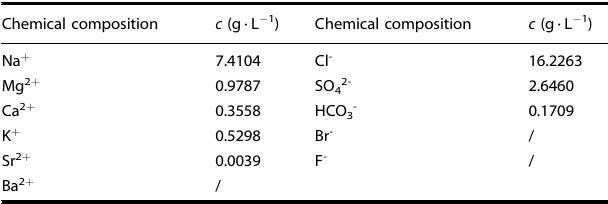
Table 2. Chemical composition of the